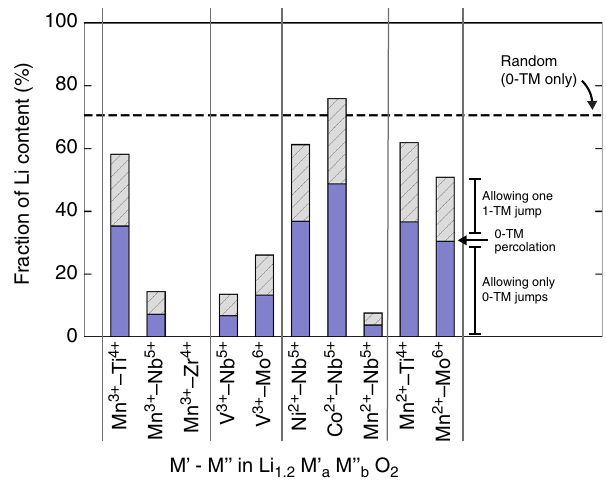
Fig. 5 Fraction of Li content made accessible by the percolating network in a speci fi c DRX Li 1.2 M ’ a M ” b O 2 . Two conditions are considered: allowing only 0-TM jumps (blue), or allowing any given Li to make a single 1-TM jump before reaching the 0-TM percolating network (gray). A percolating Li level is considered the lower bound of accessible Li. The dotted line marks the fraction of Li accessible within the 0-TM percolating network in the random structure limit. The stoichiometry of each Li 1.2 M ’ a M ” b O 2 compound is constructed such that charge neutrality is retained. The various combinations of TM species M ’– M ” are indicated along the x -axis